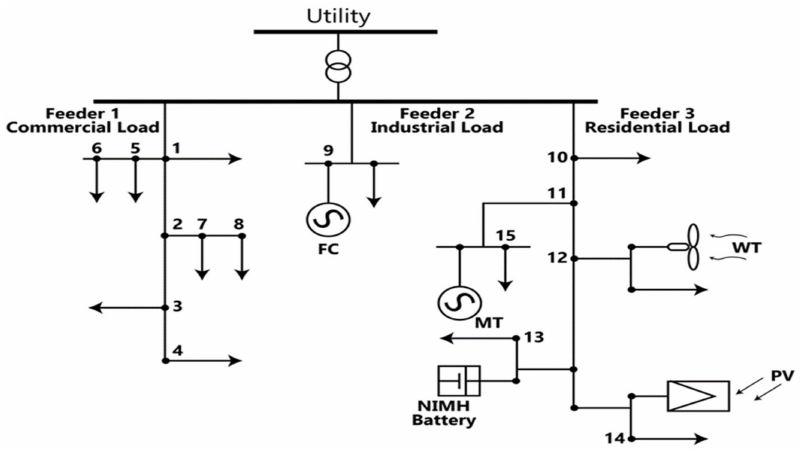
Figure 5. Single line diagram of microgrid.